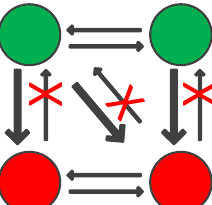
Figure 5. Cost Propagation Path Defined by Reliable Pixels and Unreliable Pixels